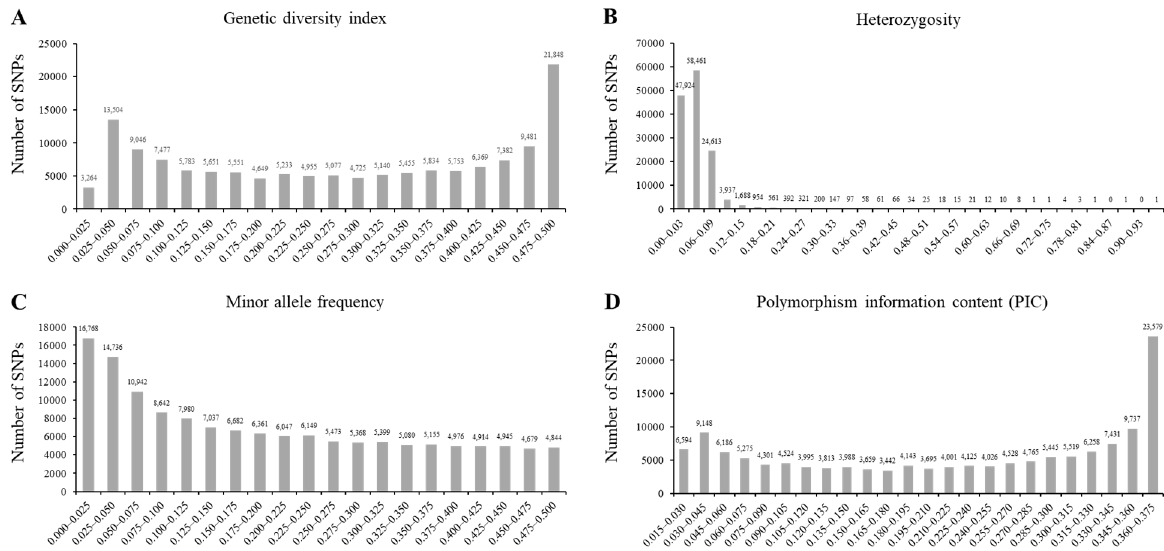
Figure 2. The genetic diversity analyses of core subset of wild soybean collections. Genetic diversity index with 180 K SNP genotype ( A ), heterozygosity with 180 K SNP genotype ( B ), minor allele frequency with 180 K SNP genotype ( C ), and the polymorphism information content (PIC) ( D ) of 142,177 SNPs across 408 wild soybean collections with green cotyledon and 3